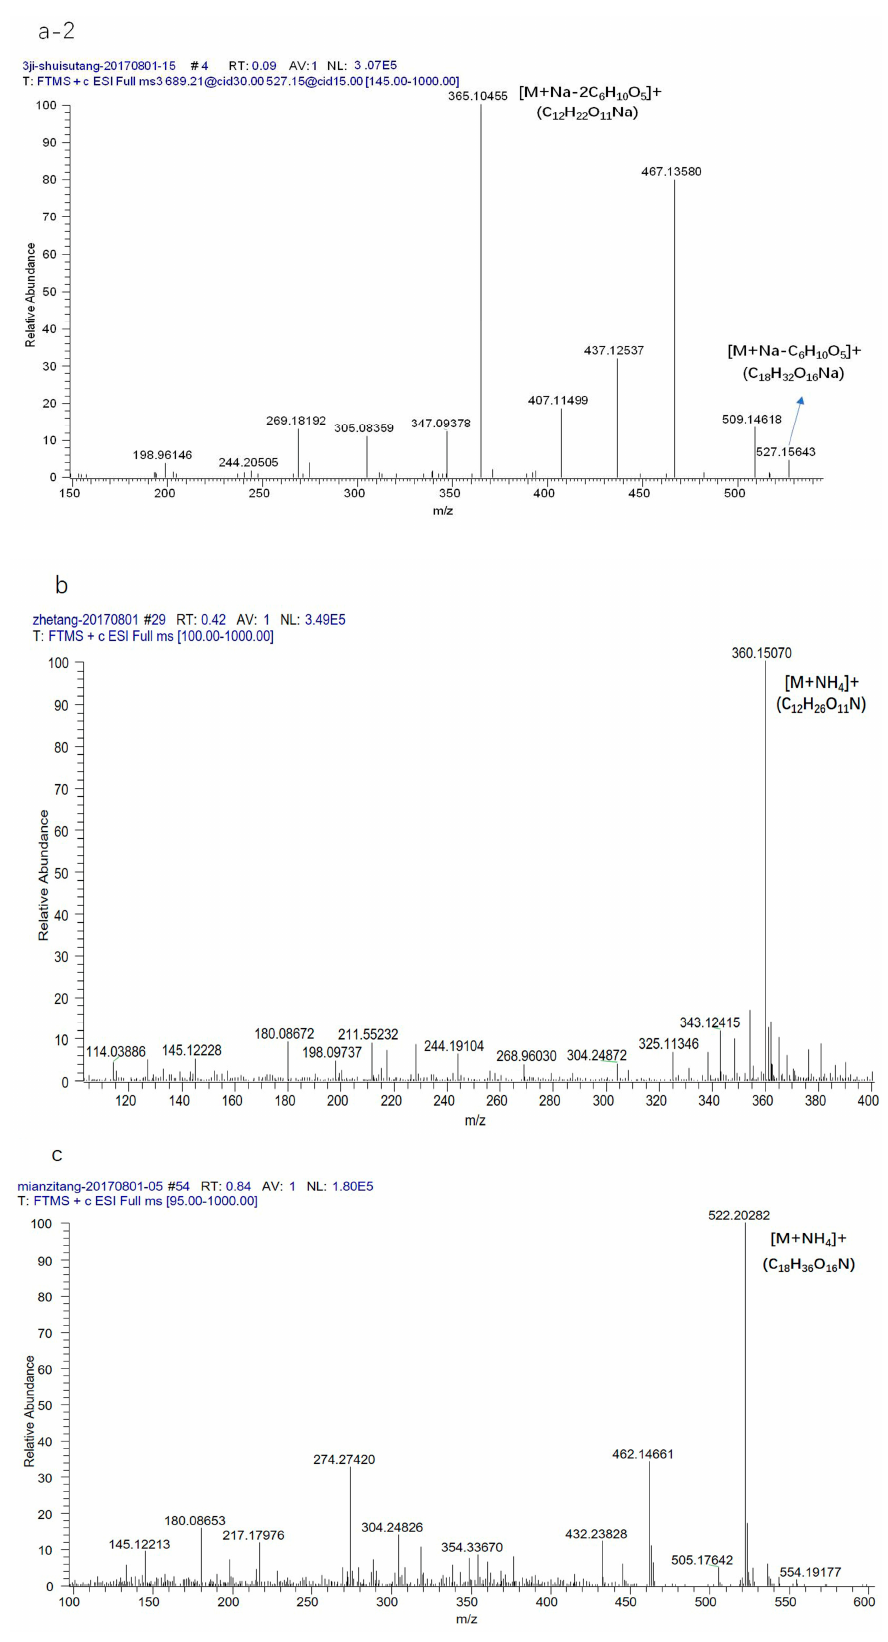
Figure 5. The collision-induced dissociation (CID) MS n spectrum of the standard of ( a-1 , a-2 ) stachyose; ( b ) sucrose; and ( c ) raffinose.